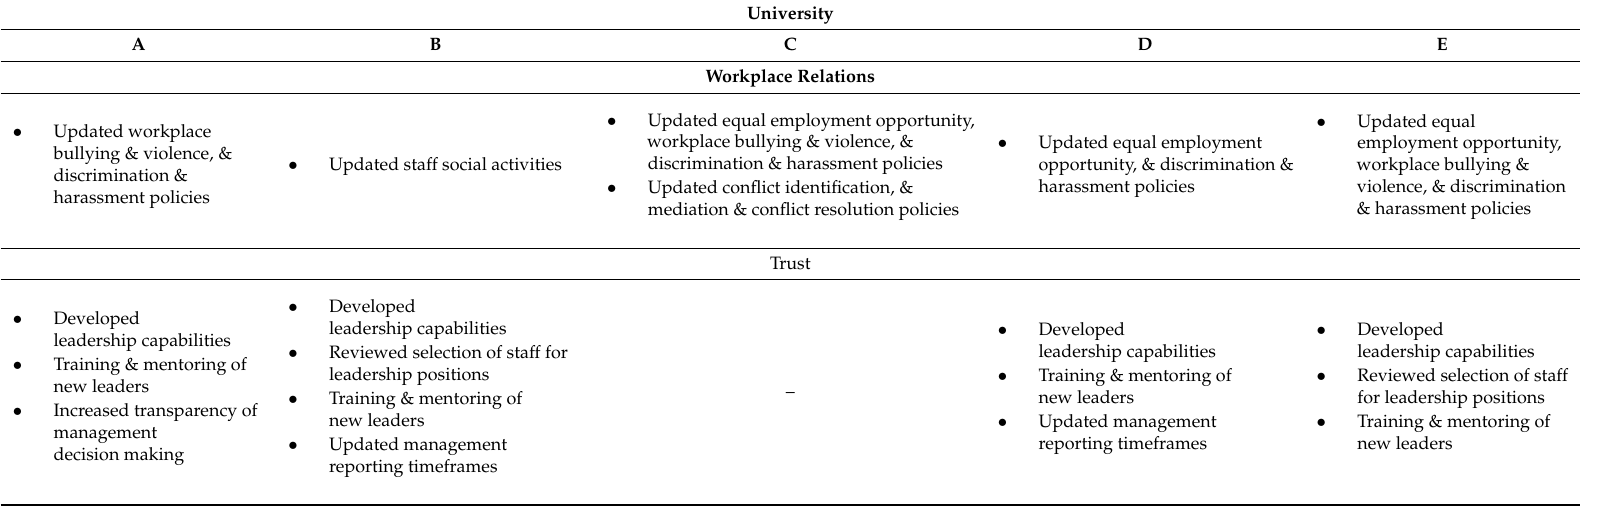
Table 5. Interventions to Enhance Workplace Relationships and Trust in Senior Management.